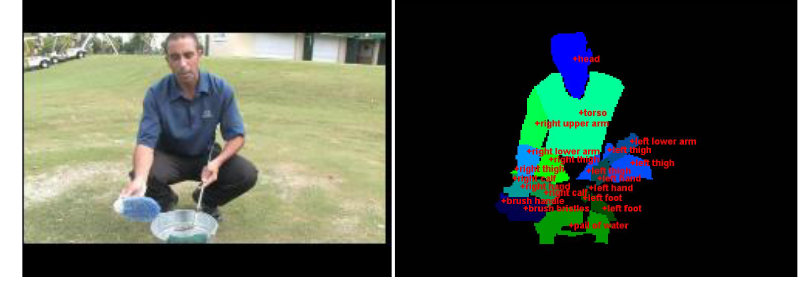
Figure 3. (left) Training image 1005, (right) Region of interest for each part.